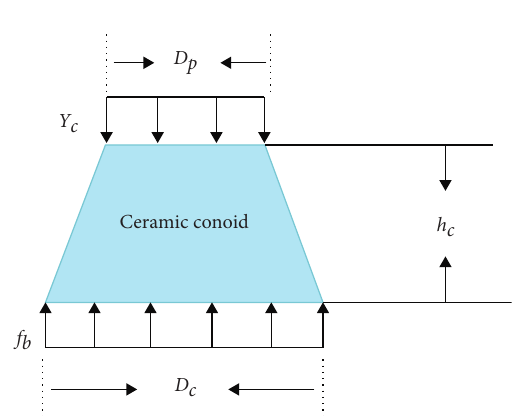
Figure 5: Ceramic conoid